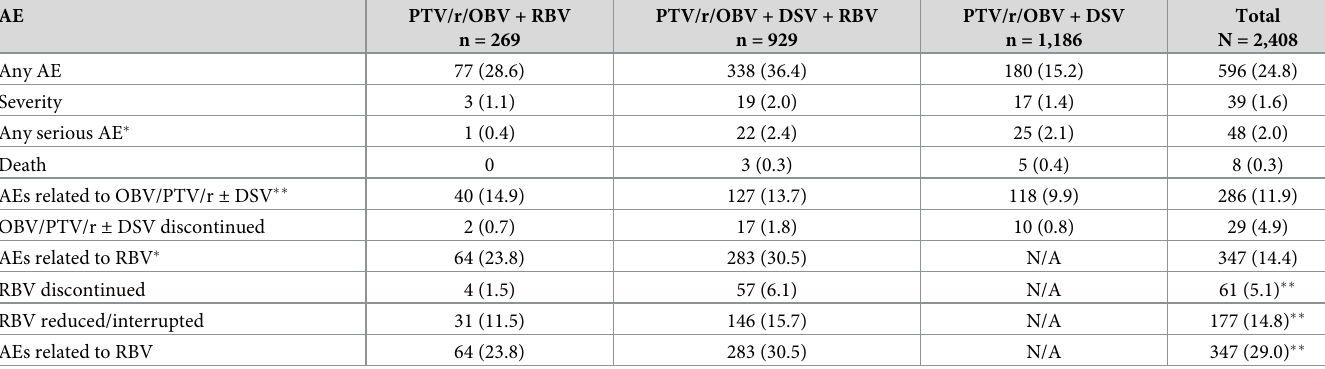
Table 4. AEs Occurring during treatment or follow-up in patients treated With OBV/PTV/r ± DSV ±